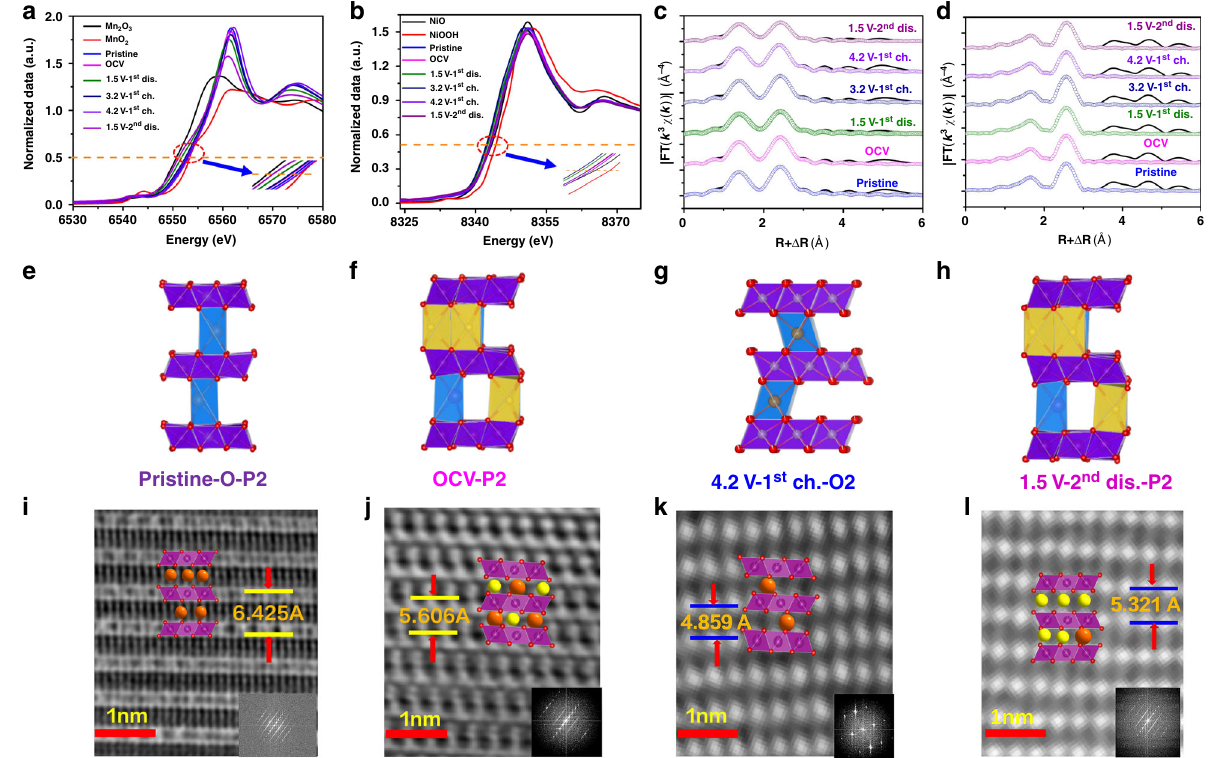
Fig. 4 Charge transfer and STEM images of O-P2 K 0.4 Ni 0.2 Mn 0.8 O 2 during cell operation. a Mn and b Ni K-edge ex situ XANES spectra collected at indicated states. Spectra of reference materials were presented for comparison. c Shell-by-shell fi tting results for the Fourier-transformed EXAFS of Mn and d Ni in the same states. The most energetically favorable structures suggested by DFT calculations at the state of e Pristine, f OCV, g 4.2 V-1 st charge, and h 1.5 V-2 nd discharge. These results match well with the following STEM images: i ABF-STEM image of pristine K 0.4 Ni 0.2 Mn 0.8 O 2 , j OCV, and HAADF- STEM image of K 0.4 Ni 0.2 Mn 0.8 O2 (H-P2) at the state of k 4.2 V-1 st charge and l 1.5 V-2 nd